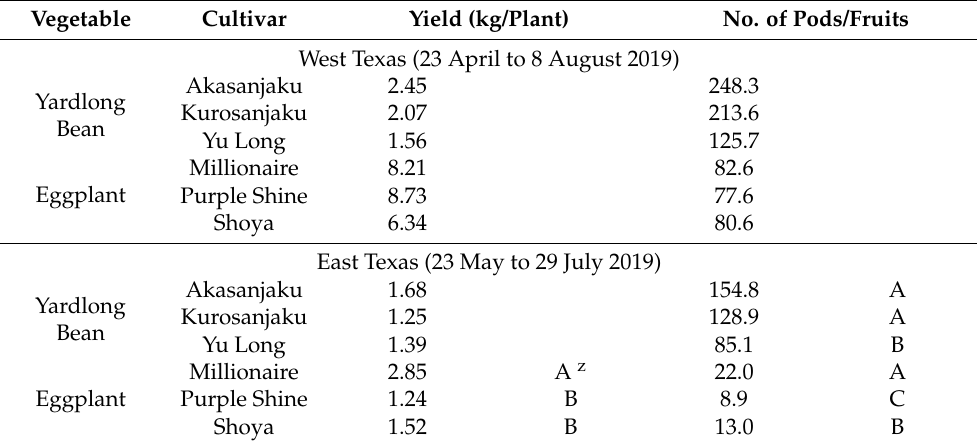
Table 6. Yield of warm season crops in West and East